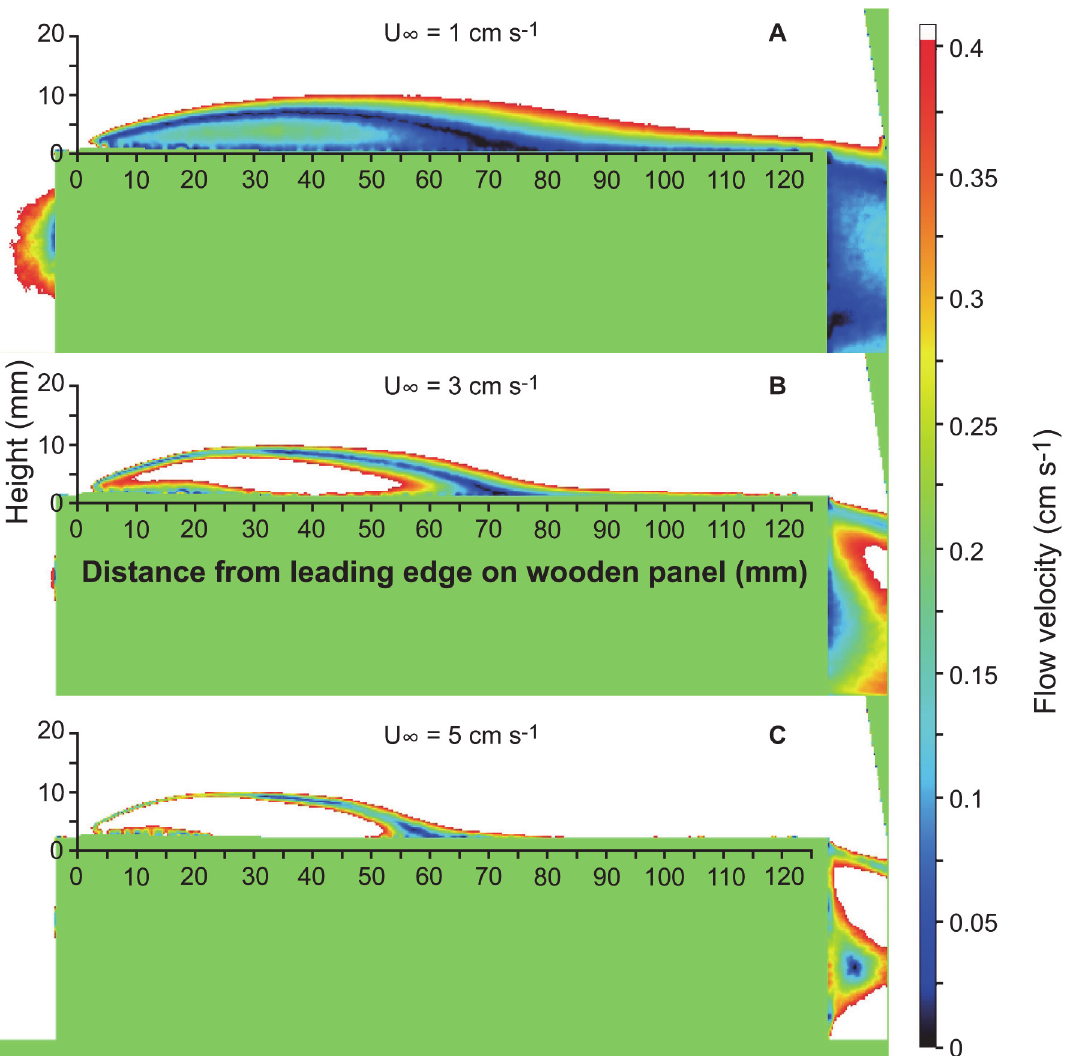
Fig 5. Laboratory flume experiment. Flow velocity fields around wooden panels measured with particle image velocimetry (PIV). Green color represents masked out areas that could not be analyzed and these are somewhat larger than the wooden panel. Coloured areas represent flow velocities below 0.4 cm s -1 i.e. twice the competent shipworm larva swimming speed. In white areas the flow velocity exceeds 0.4 cm s -1 .